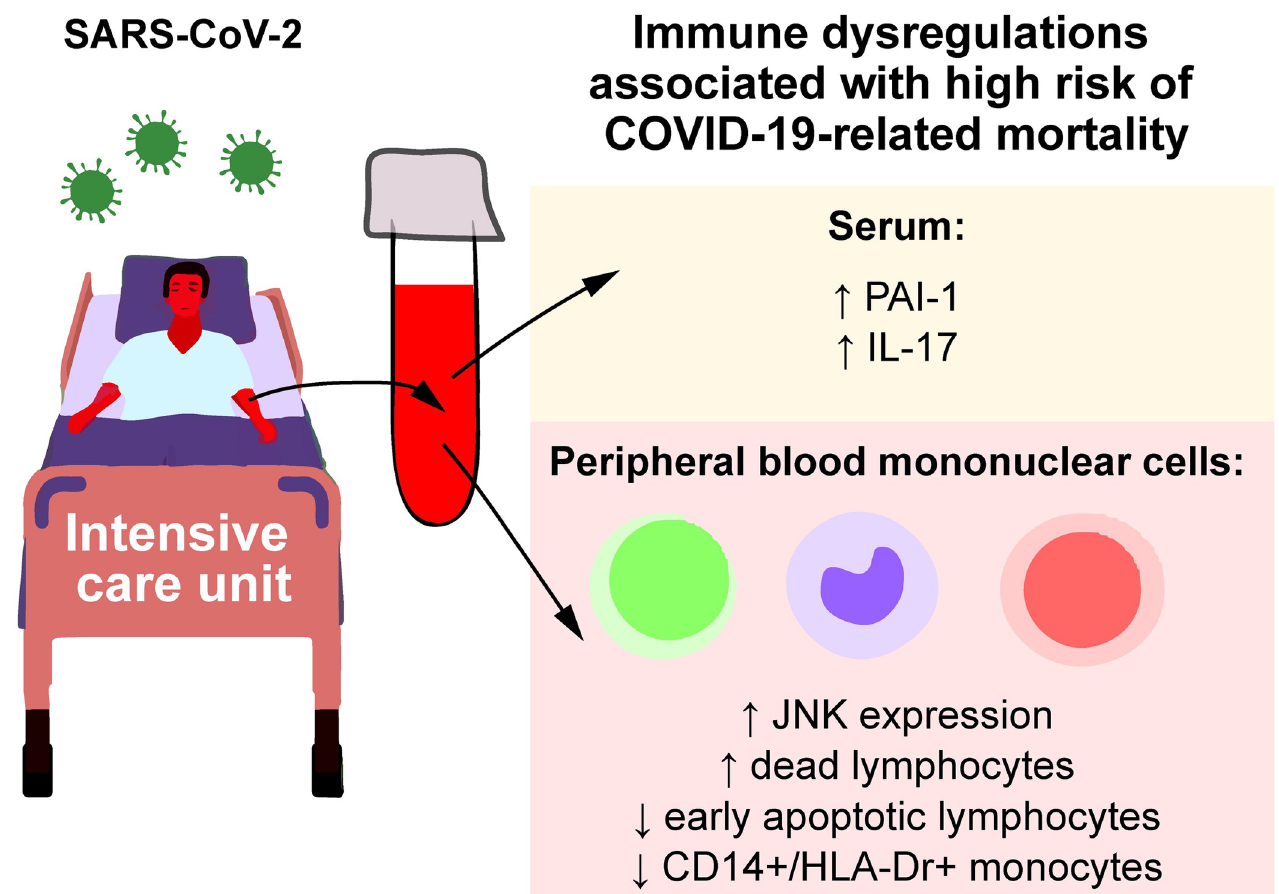
Fig 4. Novel factors that suggest a high risk of COVID-19-related death overtime in patients with severe COVID-19 admitted to ICU.